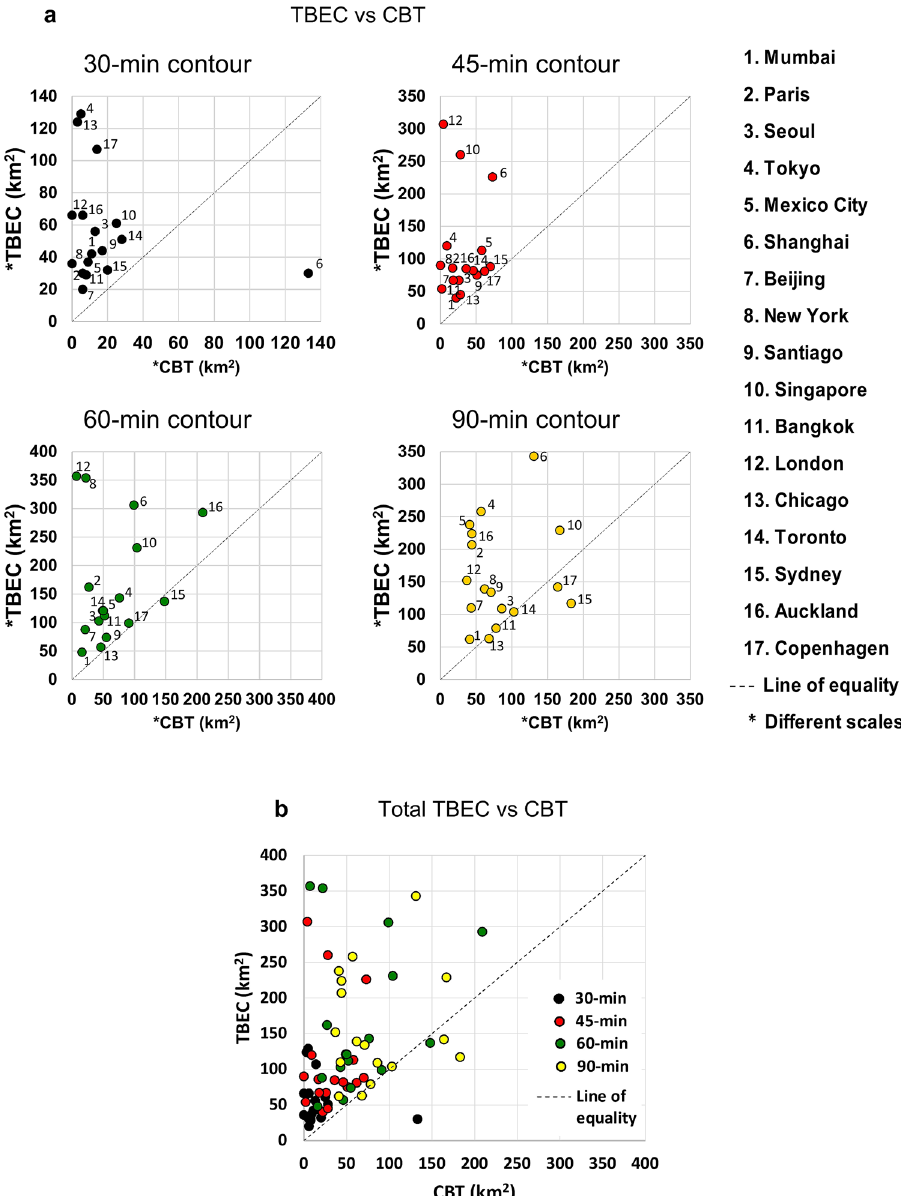
Figure 3. Comparison of fastest travel mode between PT and PCs for 17 cities (Supplementary Tables 2, 3 and 4). ( a ) Data points of the 17 cities for four contour maps, where, in referring to Fig. 2, TBEC (Transit Beats or is Equal to Cars) is the sum of the blue and green areas (in km 2 ) , CBT (Cars Beat Transit) is the pink area (in km 2 ), with city number marked as a data point. The four figures are proportional to the line of equality with different scales used for TBEC and CBT. ( b ) All data points of the four contour-map scenarios for ( a ) using the same colors as for the ( a ) data